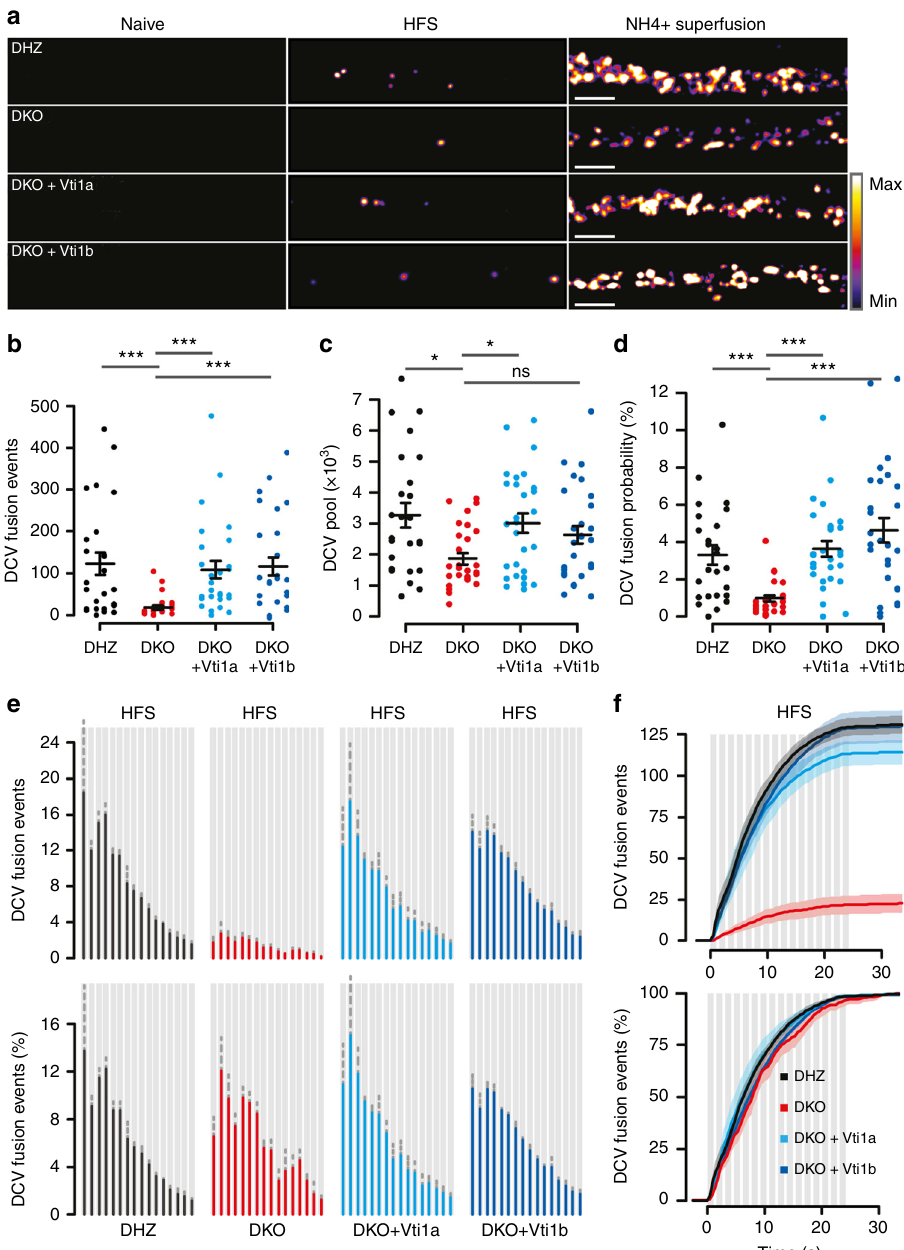
Fig. 3 Reduced dense-core vesicle secretion in Vti1a/b-de fi cient neurons. a Representative examples of single DIV-14 neurons expressing NPY-pHluorin, before, during HFS (16 trans, 50APs at 50 Hz) and after NH 4 + superfusion. Scale bar = 5 µ m. Images show maximum projections of time-lapse recordings. b DCV fusion is reduced in DKO neurons (DHZ: 123.6 ± 26.4; DKO: 18.9 ± 4.5; DKO + Vti1a: 108.5 ± 20.7; DKO + Vti1b: 119.8 ± 22.1 fusion events/neuron; Kruskal – Wallis). c Reduced DCV pool, calculated upon NH 4 + superfusion, in DKO neurons (DHZ: 3259.9 ± 395.8; DKO: 1865.0 ± 182.3; DKO + Vti1a: 2997.6 ± 314.7; DKO + Vti1b: 2697.0 ± 294.4 DCVs/neuron; Kruskal – Wallis). d Decreased DCV fusion probability in DKO neurons (DHZ: 3.29 ± 0.51; DKO: 0.96 ± 0.17; DKO + Vti1a: 3.60 ± 0.43; DKO + Vti1b: 4.59 ± 0.67%; Kruskal – Wallis). e , f Histogram and cumulative plots of the total (top) and fraction (bottom) of DCV fusion events per stimulation train (gray bars). Bars show mean ± SEM. Bullets and columns represent individual observations and independent litters, respectively. Gray bars represent 16 × 50 AP at 50 Hz stimulation. N = 25, 29, 28, 27 for DHZ, DKO, DKO + Vti1a and DKO + Vti1b, respectively. * p < 0.05, *** p < 0.001 over the rest of the soma was 16% and 23% higher, respectively expression of the postsynaptic protein PSD95 and TrKB receptors (Fig. 6l – m; Supplementary Figure 8E – G). NPY-pHluorin was also were also decreased and, like NPY-pHluorin and SNAP25, enriched in GM130- and TGN46-positive areas and the ratio of the ratio of expression inside/outside of the Golgi was greater expression was greater in DKO than controls at GM130- (57%) in DKO neurons (Supplementary Figure 9). Hence, in the and TGN46-positive areas (63%) (Fig. 6n – p, Supplementary absence of Vti1a/b, Golgi export appears to be compromised Figure 8H-J). The expression ratios for SNAP25 and NPY were for both presynaptic and postsynaptic proteins, as well as rescued by expression of either Vti1a or Vti1b (Fig. 6k – p). The DCV-cargo. NATURE COMMUNICATIONS| (2018) 9:3421 |DOI: